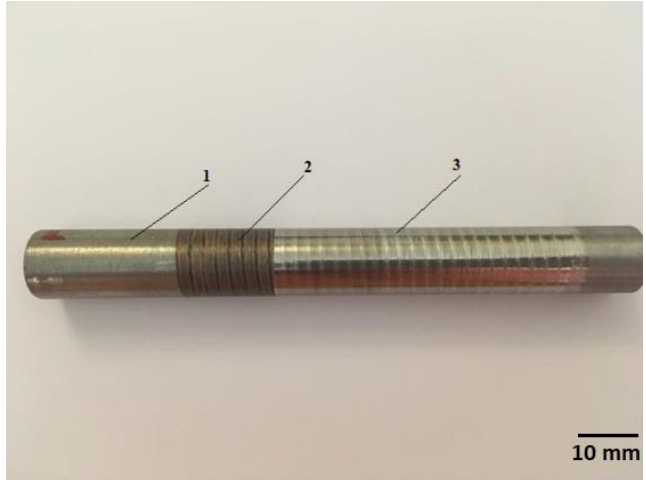
Figure 3. Samples for research: 1—area after machining, 2—area after electromechanical processing, 3—area after diamond smoothing.